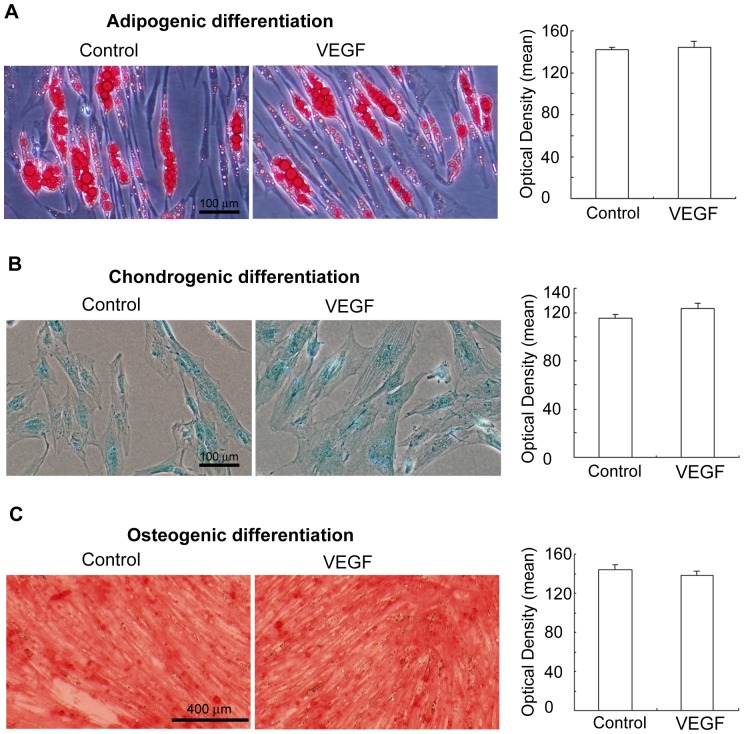
The multipotency maintenance of ADSCs after VEGF treatment.The VEGF treatment group showed similar efficiency in terms of multipotency. Relative optical intensity for adipocytes, chondrocytes and osteocytes were quantified from the images using Image-pro plus software. There was no statistic difference between the VEGF treated group and untreated group. The values were mean ± SEM (n = 3, P>0.05). (A) adipogenic potential; (B) chondrogenic potential (B); and osteogenic potential (C).